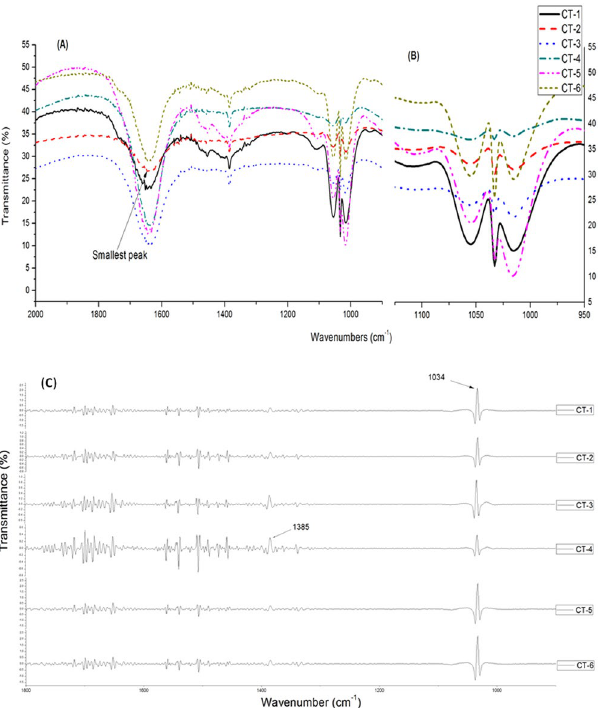
Figure 3. FTIR-spectra of six populations of C. tora collected from Dehradun (CT-1), Lucknow (CT-2), Varanasi (CT-3), Patna (CT-4), Ranchi (CT-5), and Puri (CT-6). ( A ) A portion of phytochemically important region (1800-900 cm − 1 ); ( B ) An enhanced view; ( C ) Secondary derivatives of FTIR-spectra of six population of C. tora